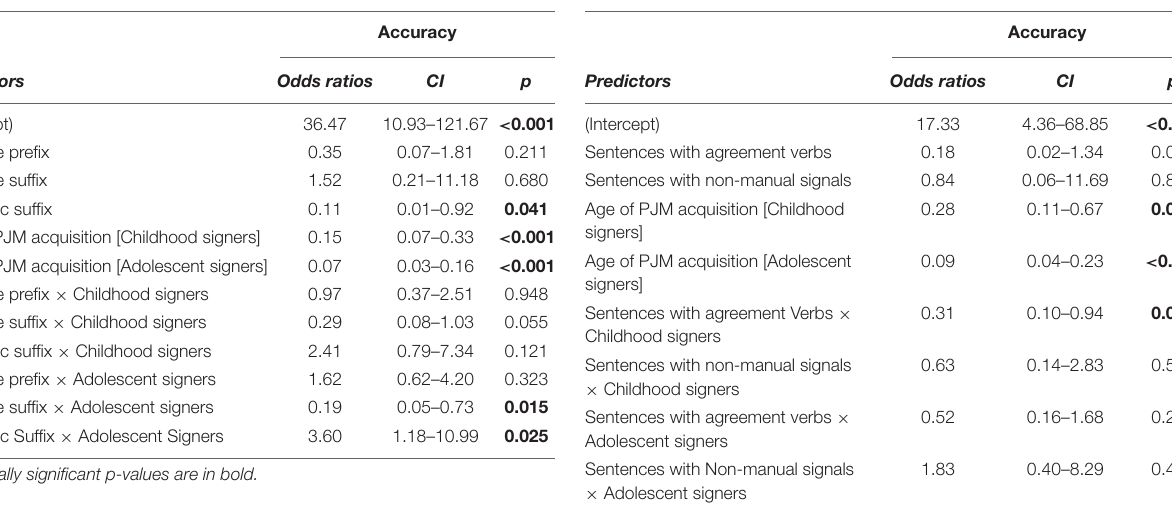
TABLE 7 | The coefficients of a generalized linear mixed-effects two-factor model with fixed effects of morphological structure (simultaneous signs, negative prefixes, negative suffixes, and semantic suffixes) and group (native signers, childhood signers, and adolescent signers) and accuracy as the dependent variable.